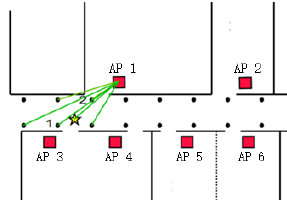
Figure 2. Schematic diagram for selecting the reference points based on the cosine similarity, with APs represented as the red “ □ ”, the yellow “*” as the non-site-surveying grids of the dense fingerprints (in other words, the grids needed to simulate RSS ), the black dots as the site-surveying grids of the coarse fingerprints (the grid with real RSS measurements), and the green lines denote the transmission path between the AP and grid pair of the simulated or measured